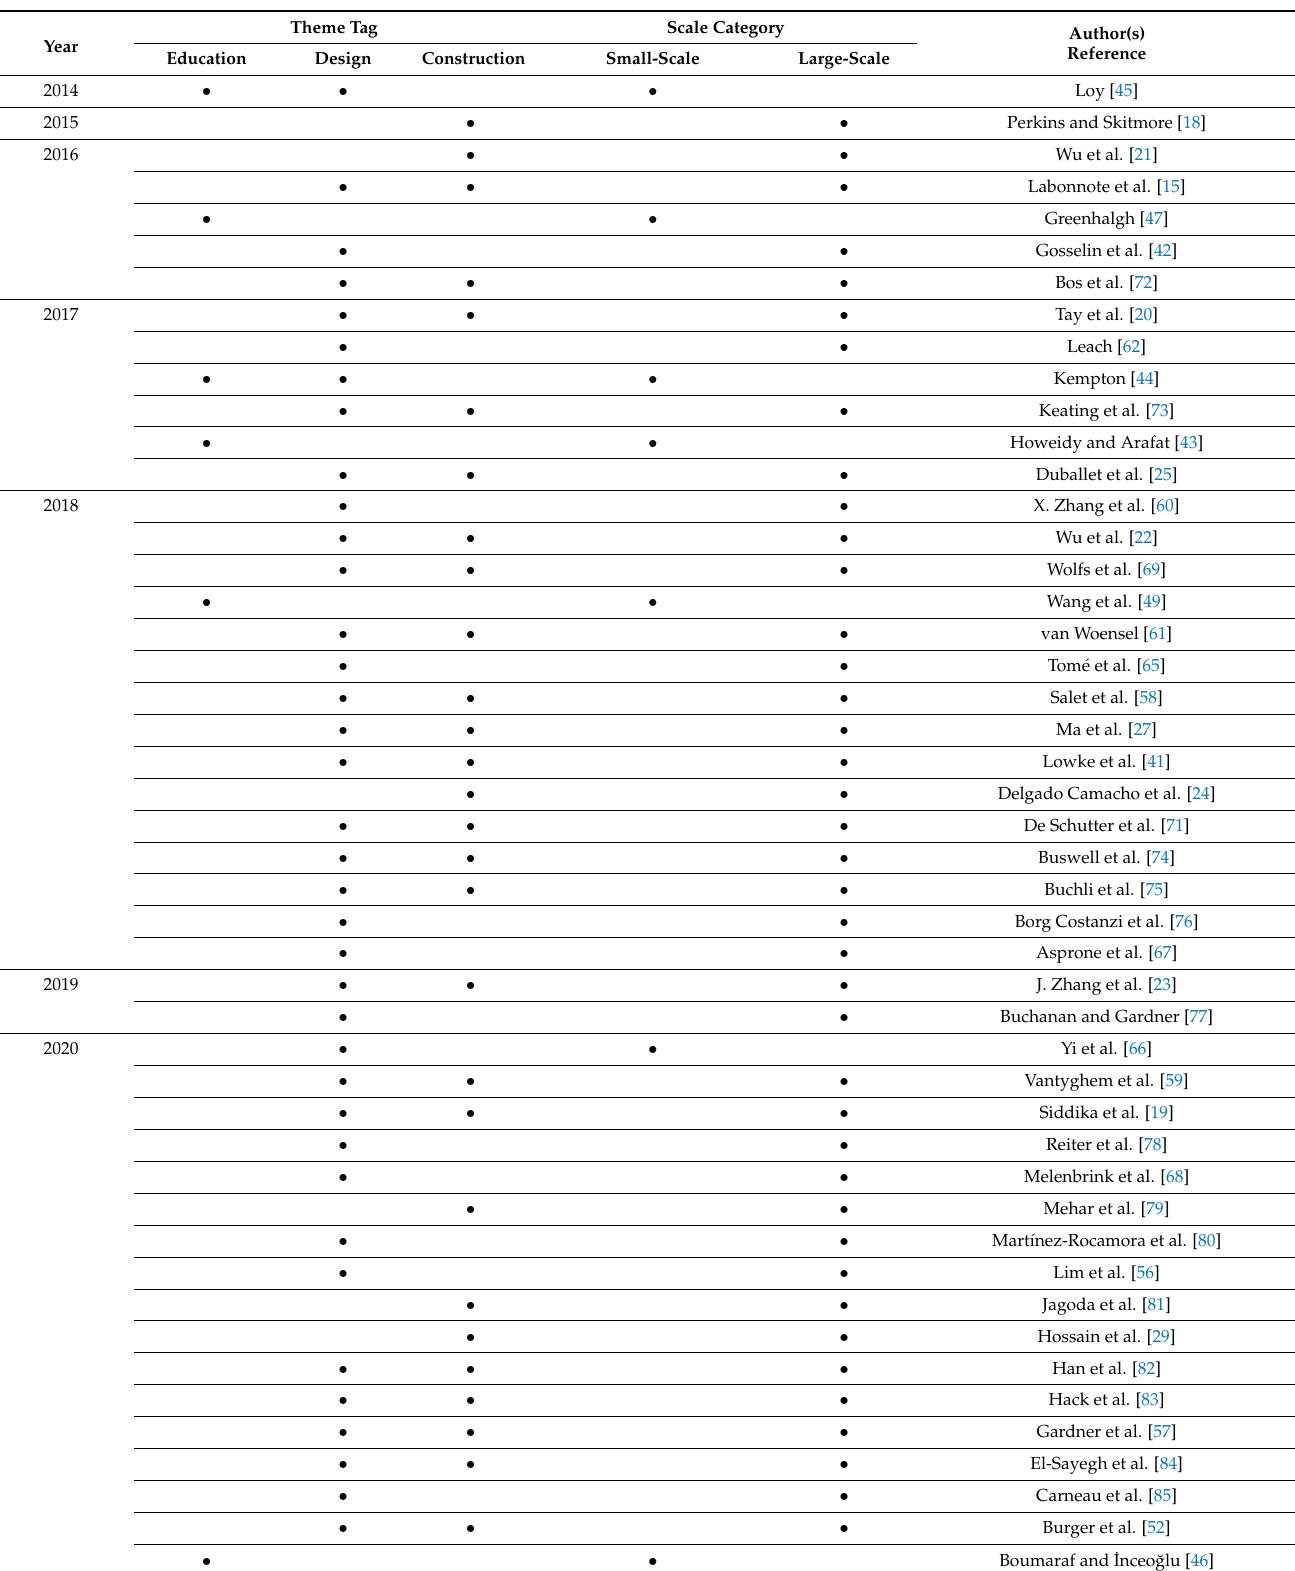
Table 6. Literature review